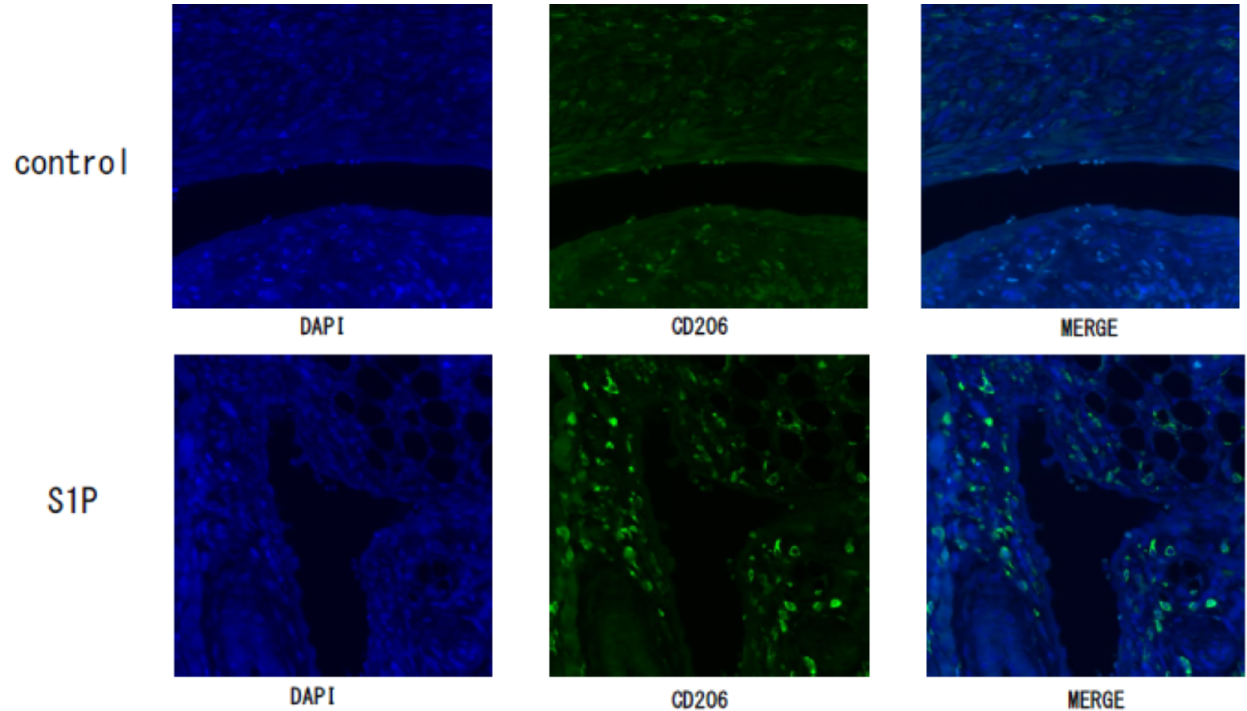
Figure 4. The expressions of CD206 in the endometriotic-like lesion in control and S1P-treated endometriosis mouse model. Endometriotic-like lesions from control or S1P-treated mice were stained with an antibody of CD206, a marker of macrophages. As a secondary antibody, the gout anti-rabbit antibody was used and 4 ′ ,6-diamidino-2-phenylindole (DAPI) was used to detect nuclei.